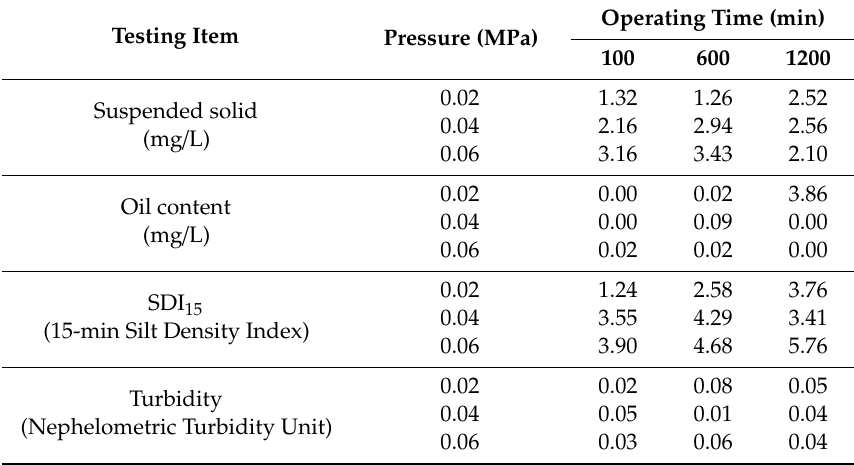
Table 2. Analysis of UF filtrate.